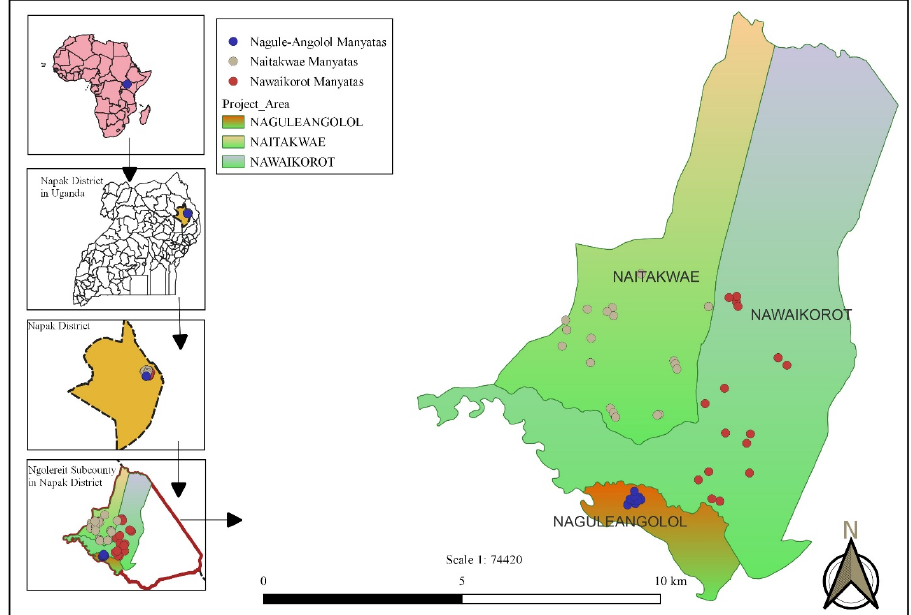
Figure 1. Map showing the location of the manyatas in the three study parishes.